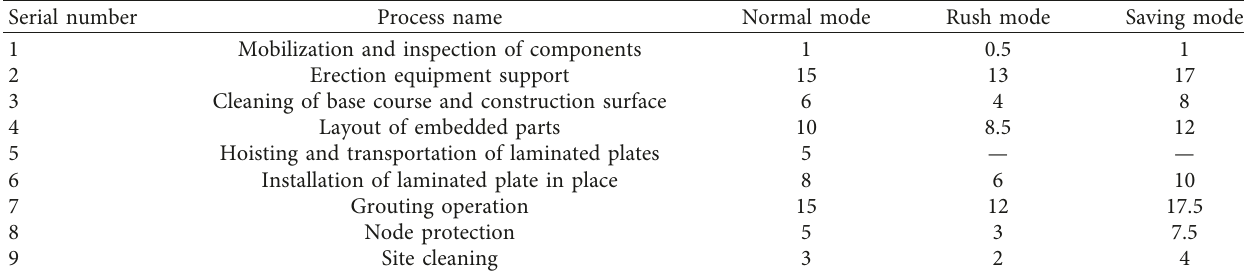
Table 4: Summary of construction period data of installation process of laminated plate components (min).